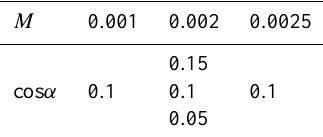
Table 2. M and cos α for solitary wave solutions found in Figs. 5 and 6 and indicated by black-edged white circles in Fig.